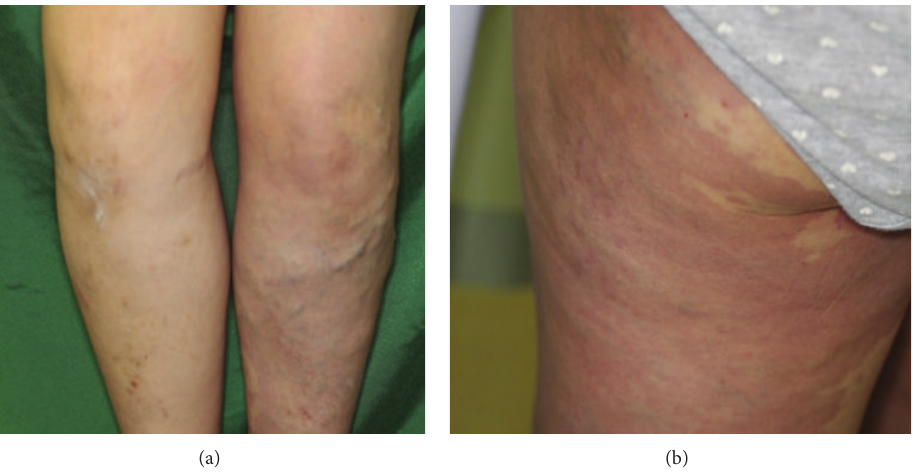
Figure 1: The patient had varices (a) and a port-wine stain (capillary malformation) on the left leg